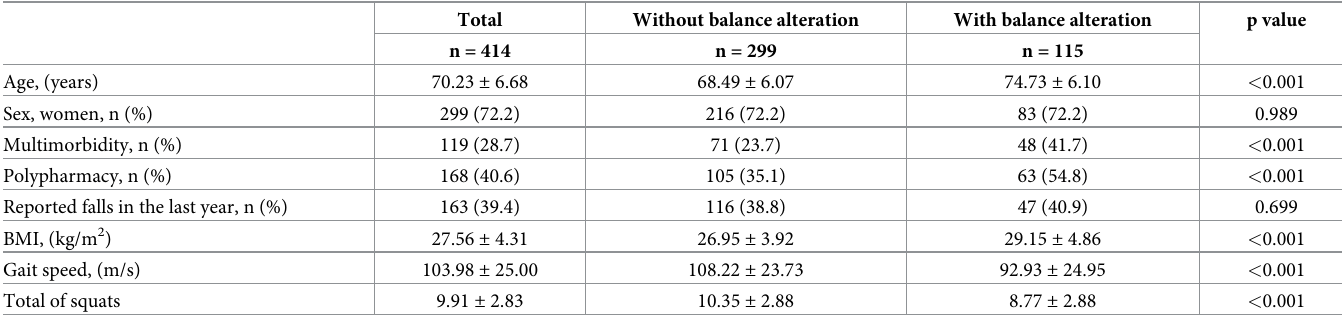
Table 1. General characteristics by balance alteration.